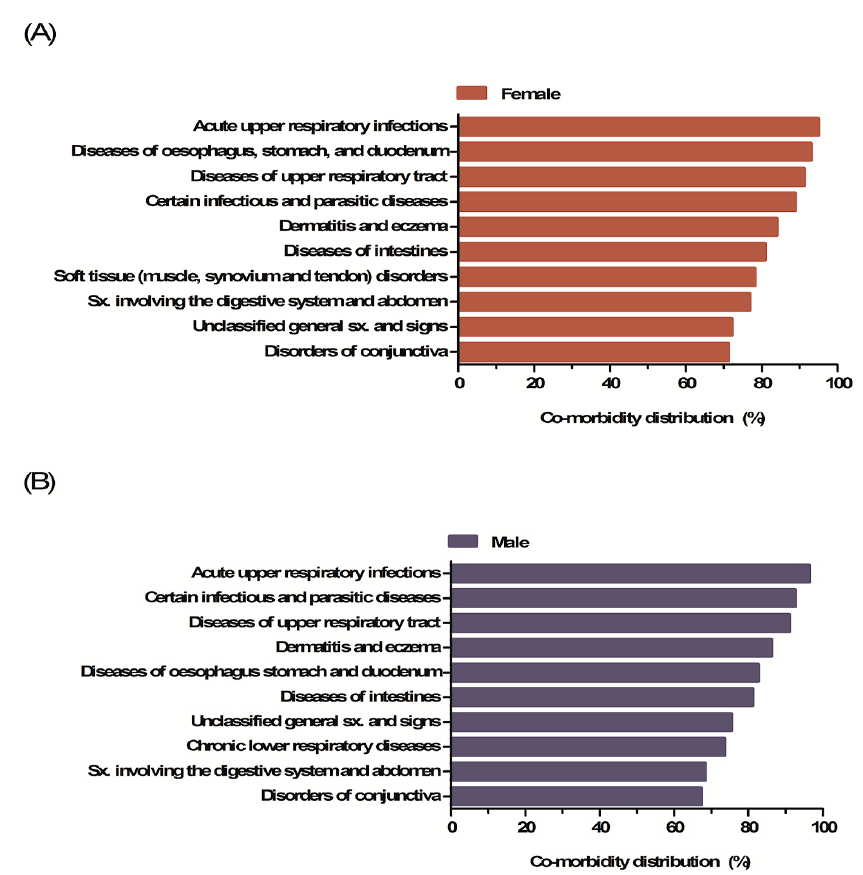
Figure 3. Co-morbidities of iron deficiency anemia. ( A ) Co-morbidities of iron deficiency anemia in females. ( B ) Co-morbidities of iron deficiency anemia in males.